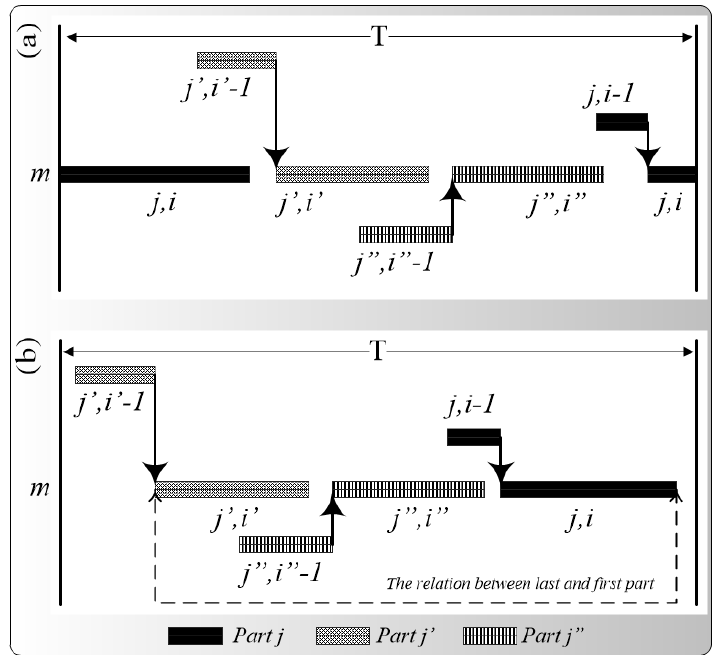
Figure 11. The operational sequencing restrictions of any machine m ; ( a , b ) presents the restriction when m is occupied and free at the start of the cycle,